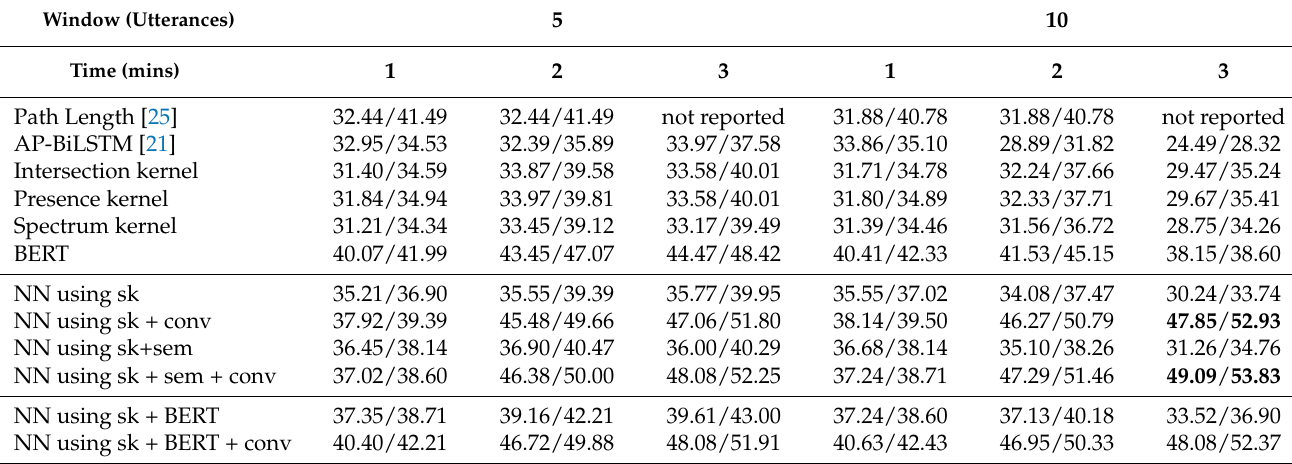
Table 4. Results for semantic links detection (Exact matching accuracy (%)/In-turn matching accuracy (%). Window